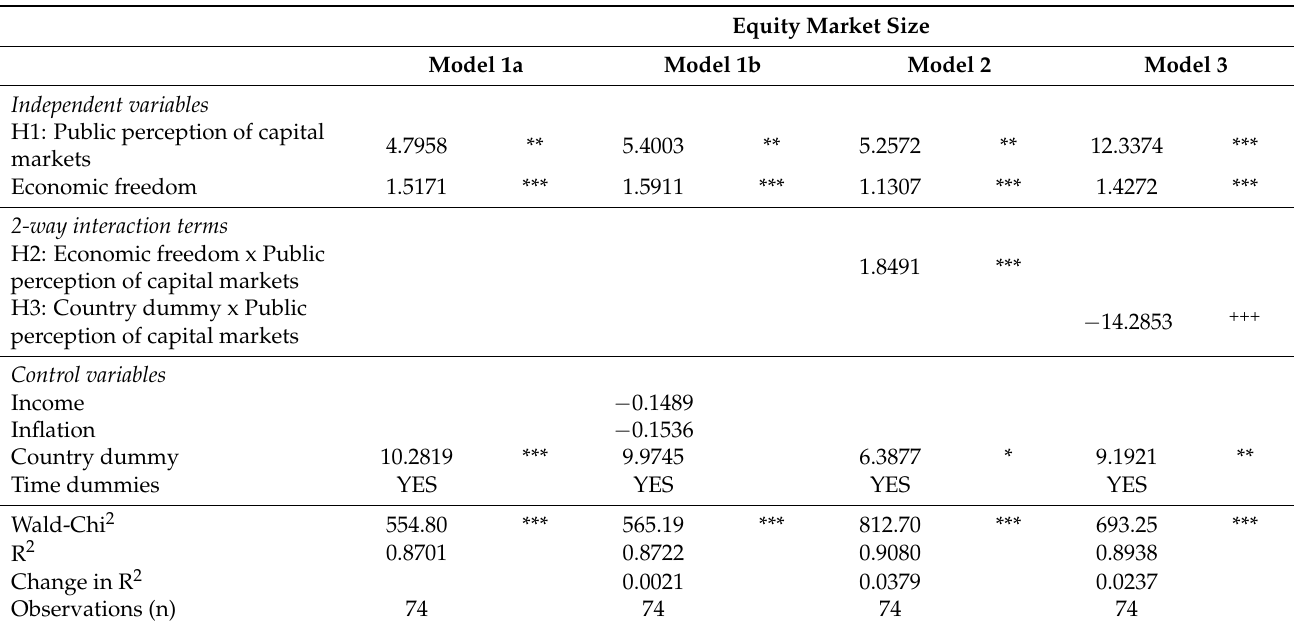
Table 4. Hierarchical regression